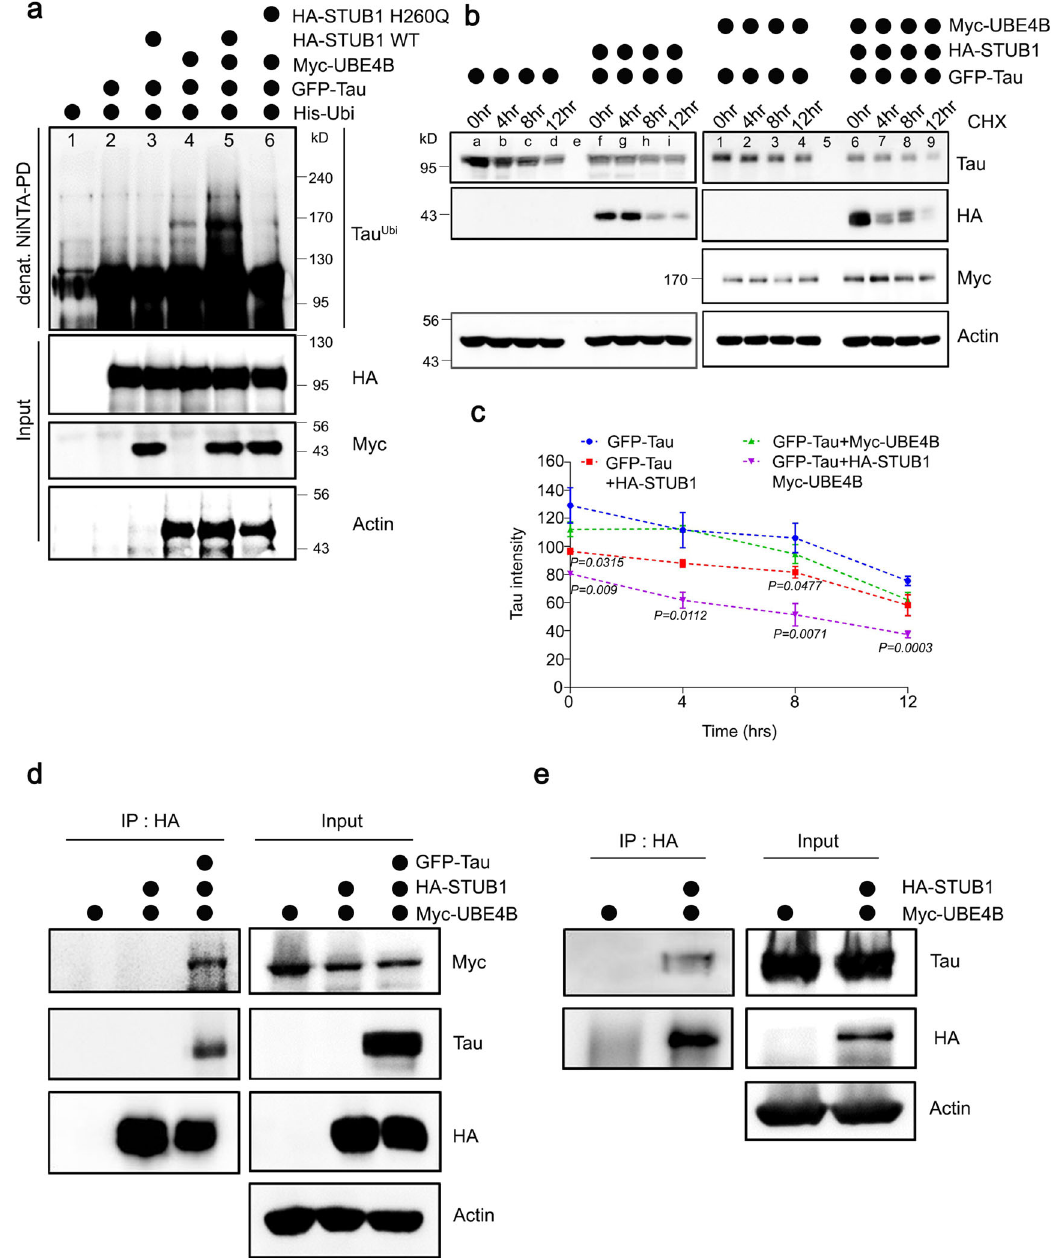
Fig. 4 Tau was ubiquitinated and degraded by UBE4B and STUB1 in mammalian neuroblastoma cells. a Tau was co-expressed with His-Ubiquitin , UBE4B , and STUB1 WT or dominant-negative mutant STUB1 H260Q in SH-SY5Y neuroblastoma cells. Ubiquitinated Tau was signi fi cantly increased by co-expression of UBE4B and STUB 1 (lane 5), but not by expression of UBE4B (lane 4) or STUB1 (lane 3) alone. Tau ubiquitination by co-expression of UBE4B and STUB1 required the ligase activity of STUB1 (lanes 5 and 6). b , c Tau protein degradation was enhanced by co-expression of UBE4B and STUB1 (lane 6 – 9) compared with expression of UBE4B (lane 1 – 4) or STUB1 (lane f – i) alone. Quanti fi cation of Tau levels was normalized to the amount of β -actin protein in each case. Data represent the mean ± s.e.m of three independent experiments (* P < 0.05, ** P < 0.005, *** P < 0.001 two-tailed Student ’ s t -test). d UBE4B was co-expressed with HA-STUB1 and Tau in SH-SY5Y cells and immunoprecipitated on anti-HA-agarose beads. UBE4B did not directly interact with STUB1 in the absence of Tau, but indirectly interacted with STUB1 in the presence of Tau. e HA-UBE4B was co-expressed with Tau in SH-SY5Y cells and immunoprecipitated on anti-HA-agarose beads. Co-precipitated Tau was detected by Western blot, revealing that Tau directly interacted with UBE4B. All western blots were performed more than three times. Statistical source